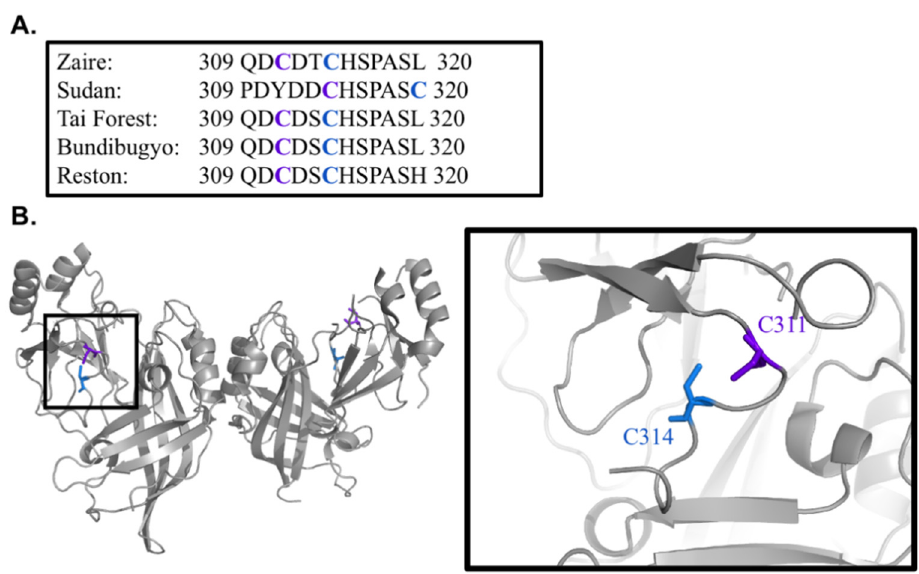
Figure 1. Ebolavirus VP40 cysteine residues are conserved. ( A ) With the exception of Sudan Ebolavirus, cysteine at 311 and 314 are conserved in ebolaviruses. ( B ) Structure of Ebolavirus Zaire VP40 (PDB ID: 4LDB) with C 311 and C 314 highlighted in the CTD loop region.